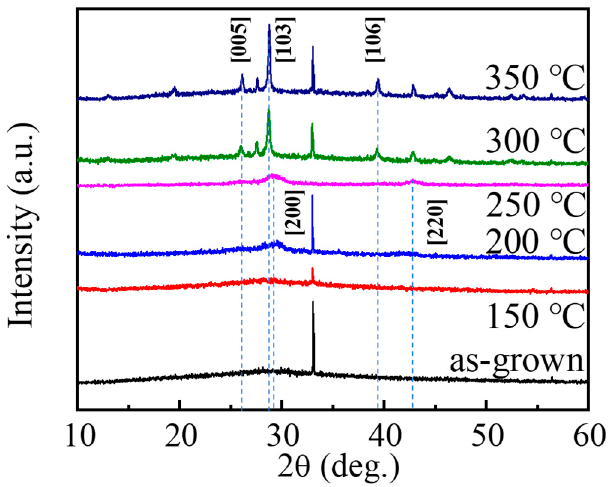
Figure 2. XRD patterns of the as-grown GST films annealed at different temperatures for 30 min.